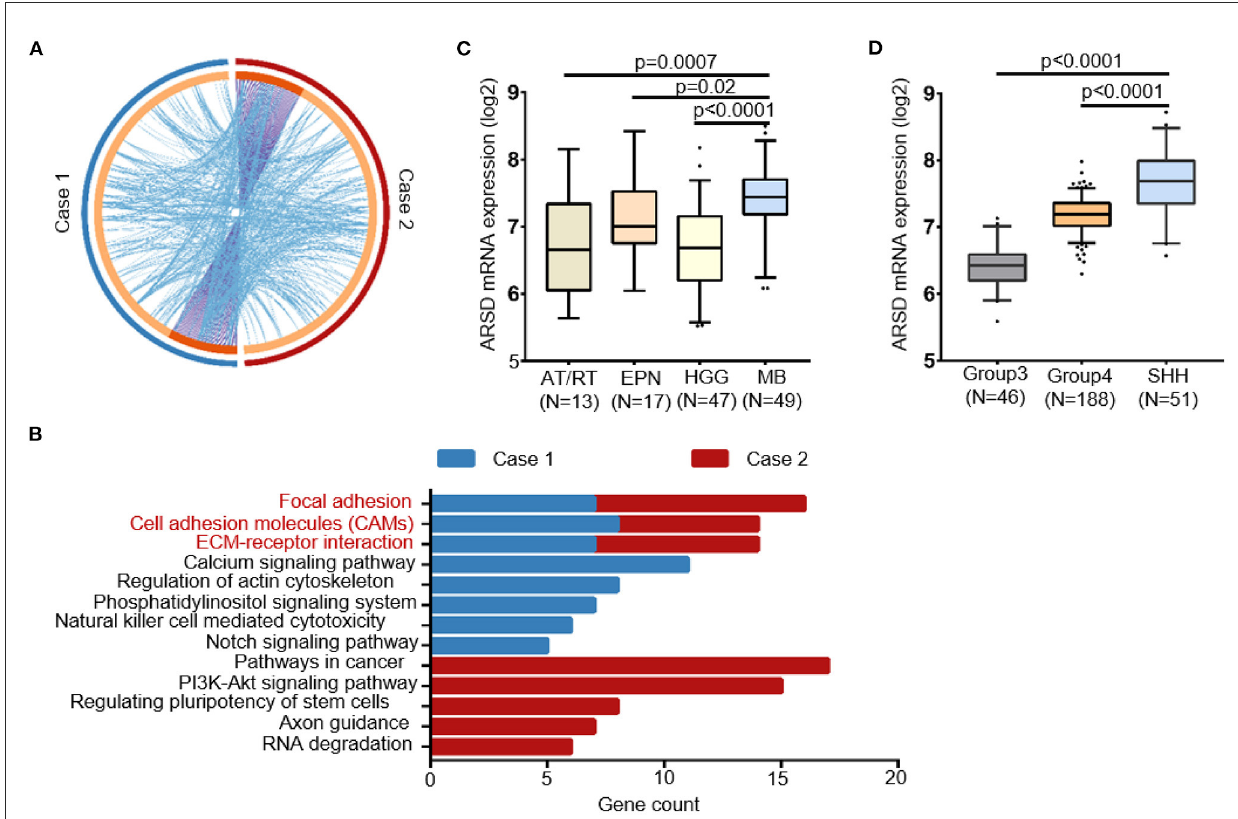
FIGURE4 Convergence of the germline mutational profile between two cases with sub-frontal recurrent MBs. (A) Significant overlap between the two germline mutational gene lists. Purple curves linked identical genes and blue curves linked genes that belong to the same enriched pathway term. Genes that hit two lists were colored in dark orange, and genes unique to a list were shown in light orange. (B) KEGG terms for germline mutational gene set of two cases from WGS data showed functional convergence in focal adhesion, cell adhesion molecules, and ECM–receptor interaction. (C) The germline mutated gene ARSD identified in both two cases had a higher expression in MBs than other pediatric tumors and (D) in SHH MBs than other subtypes, according to datasets Sturm_2016 and Northcott_2012, separately. AT/RT, atypical teratoid rhabdoid tumor; EPN, ependymoma; HGG, high-grade